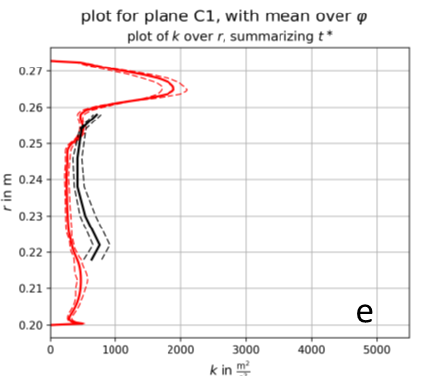
Figure 12. ( a – d ) Circumferentially averaged turbulence kinetic energy and minimum and maximum